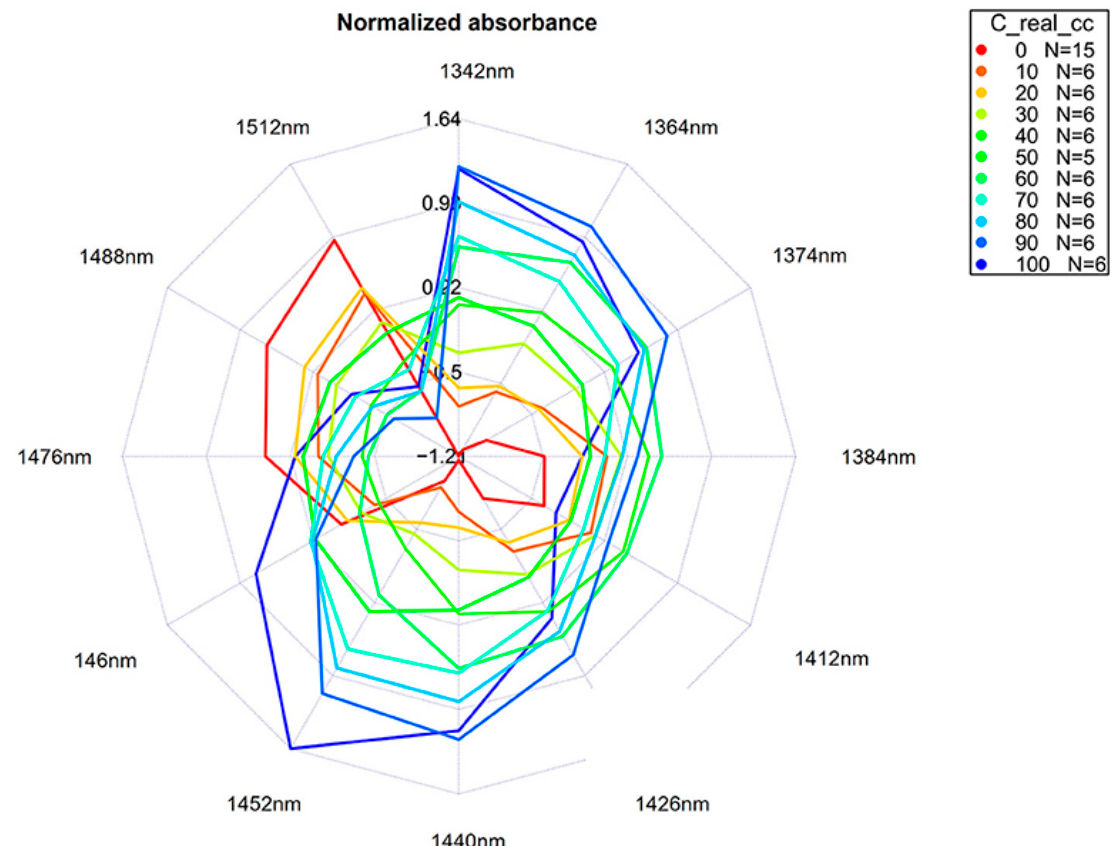
Figure 5. Aquagrams of aqueous solutions of potassium-chloride in the concentration range of 10–100 mM in the spectral range of 1300– 1600 nm (OH first overtone).